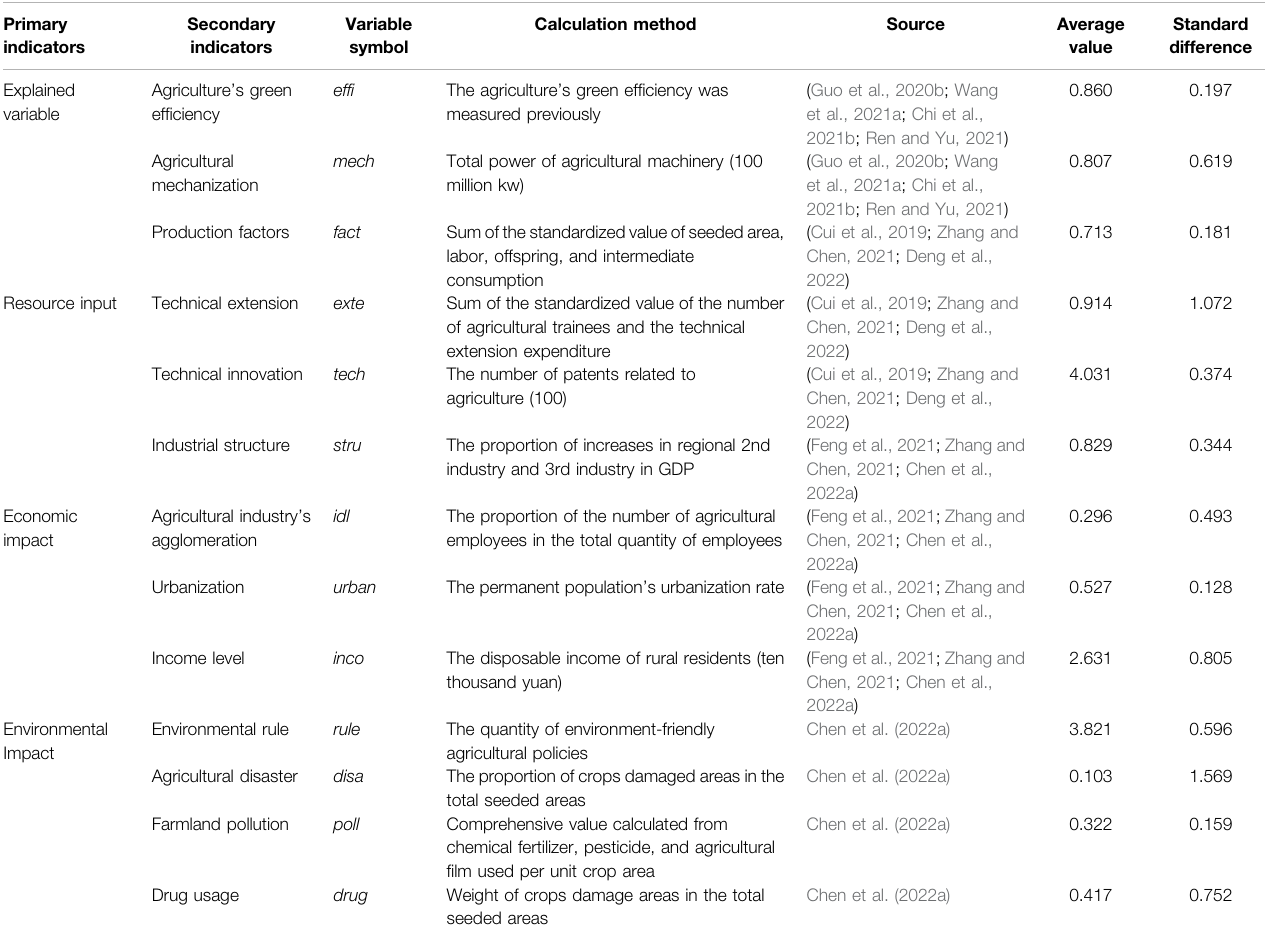
TABLE 5 | Variable description and descriptive statistical